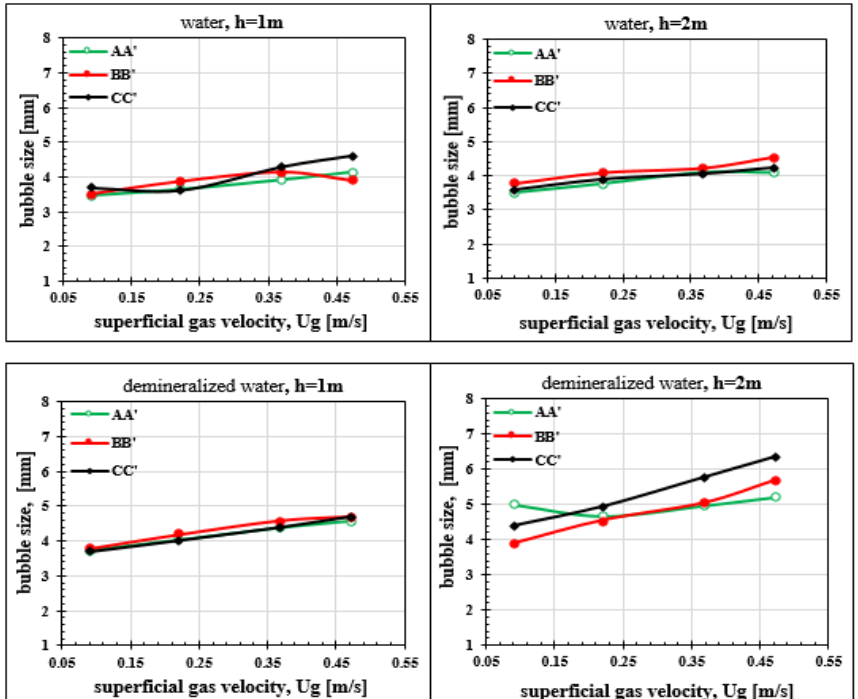
Figure 20. Relationship between bubble size and superficial gas